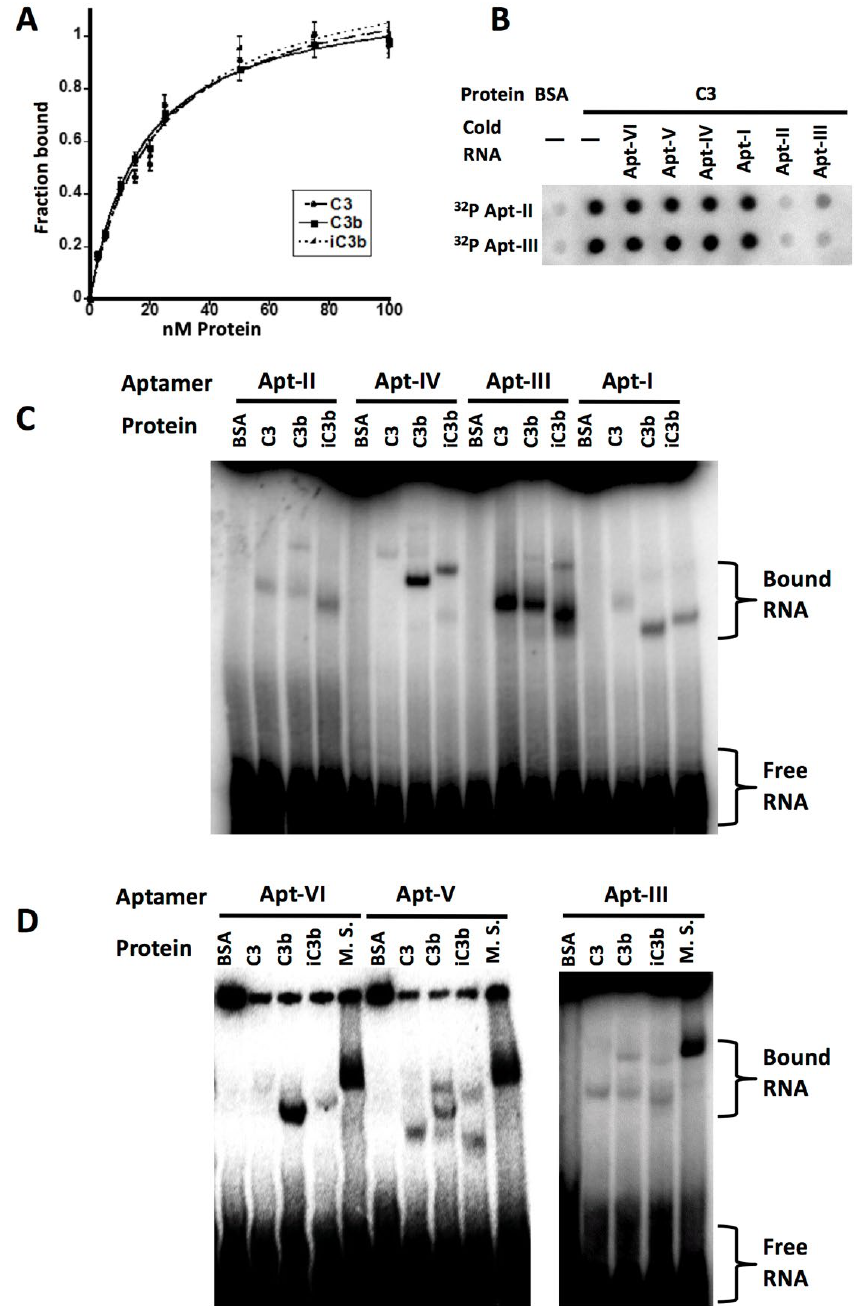
Figure 2. Characterization of C3 aptamers. ( A ) Affinity of AptC3-III as measured by filter binding. Values represent the average of three independent assays. Error bars indicate standard deviations.